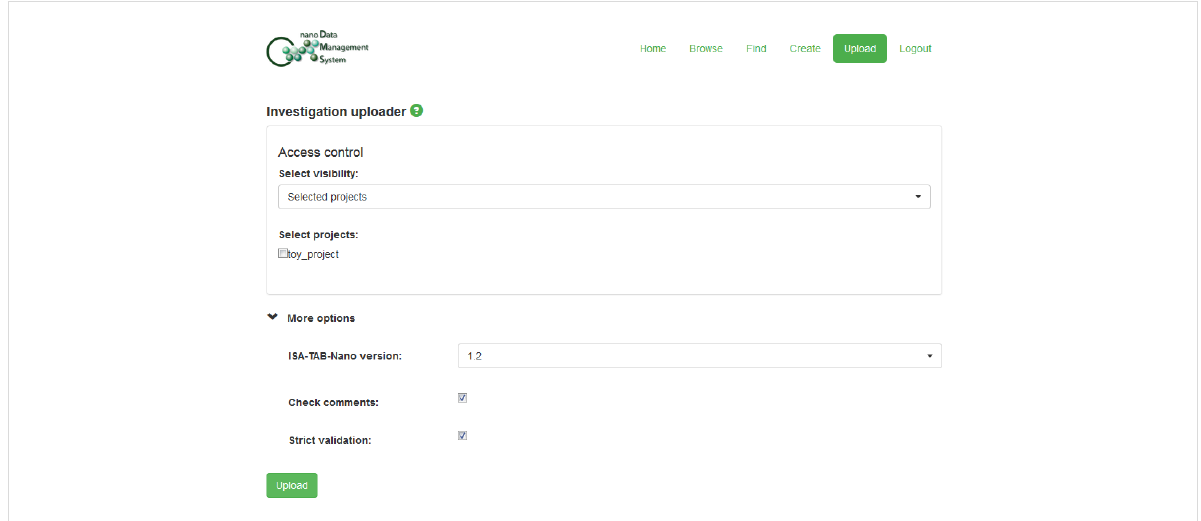
Figure 3: Upload options for loading the suitable version of the “Toy Dataset” (Supporting Information File 3) into the nanoDMS online database, which can be accessed via the cited web-address [110]: ontology identifiers were truncated and Investigation “Comment […]” rows deleted, using the Python program described in section 5, in order to enable this submission. Since these were not real data, the upload settings were selected such that the “Toy Dataset” was not publicly visible after uploading.